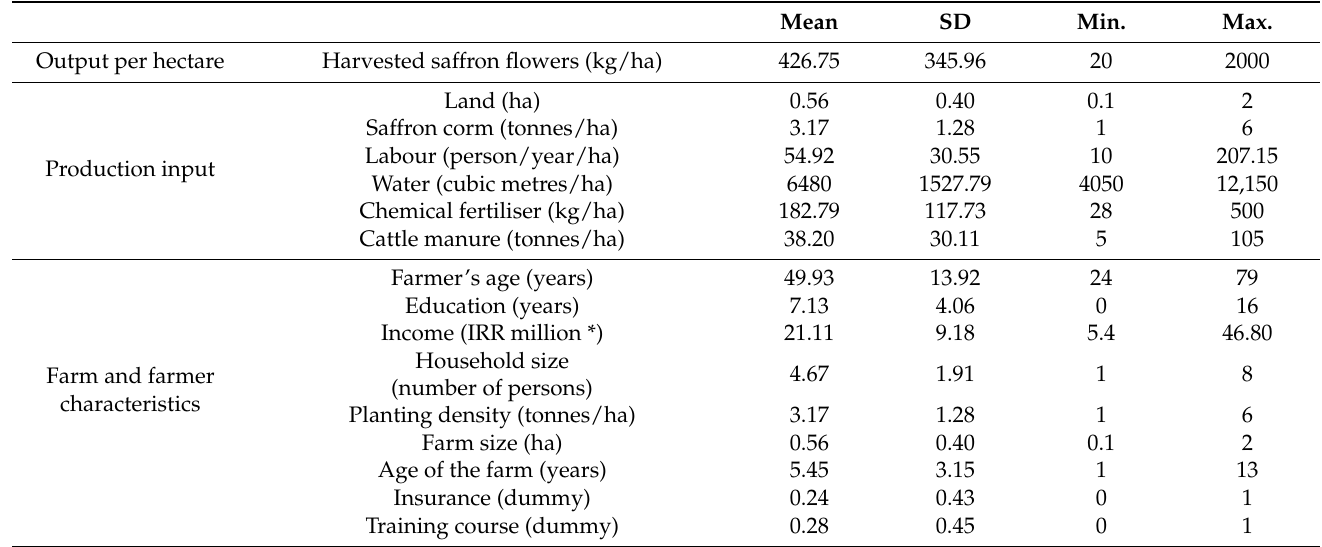
Table 1. Summary statistics for the variables obtained from the survey in the year of data collection (2019). Mean SD Min. Max.